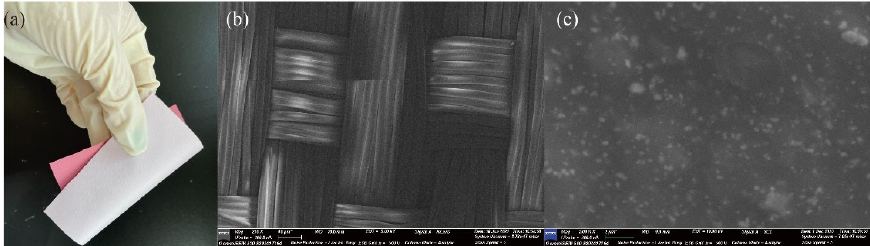
Figure 1. ( a ) TPU ‐ coated polyester fabric; ( b ) SEM of uncoated fabric surface;( c ) SEM of TPU ‐ coated fabric surface.